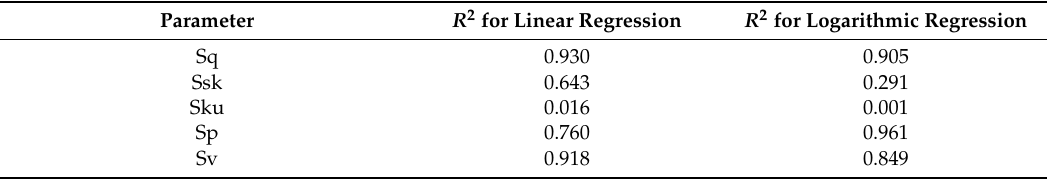
Table A3. Coe ffi cients of determination ( R 2 ) between discharge energies and ISO 25178 areal parameters calculated using linear and logarithmic regressions for primary surfaces. Please see the standard for additional settings given in the